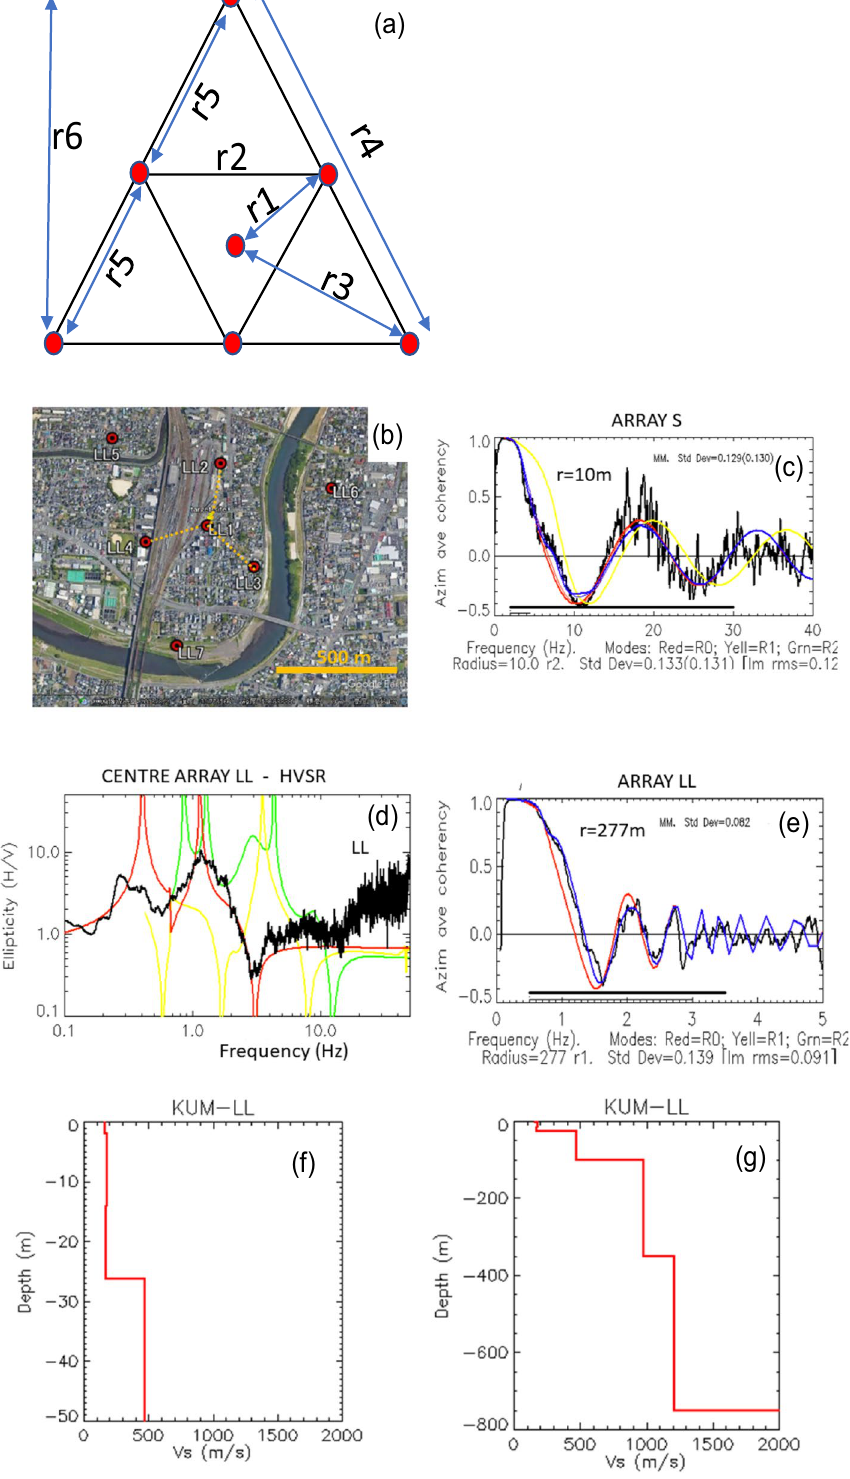
Fig. 1 (See legend on previous